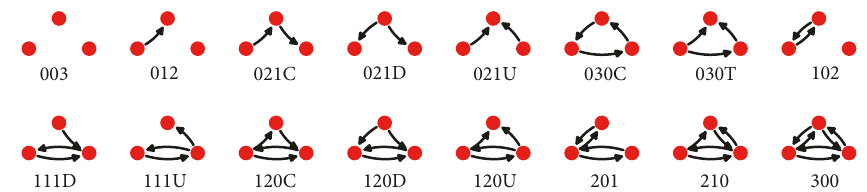
Figure 3: Triad configurations. 16 possible configurations of links between three nodes in a directed network.